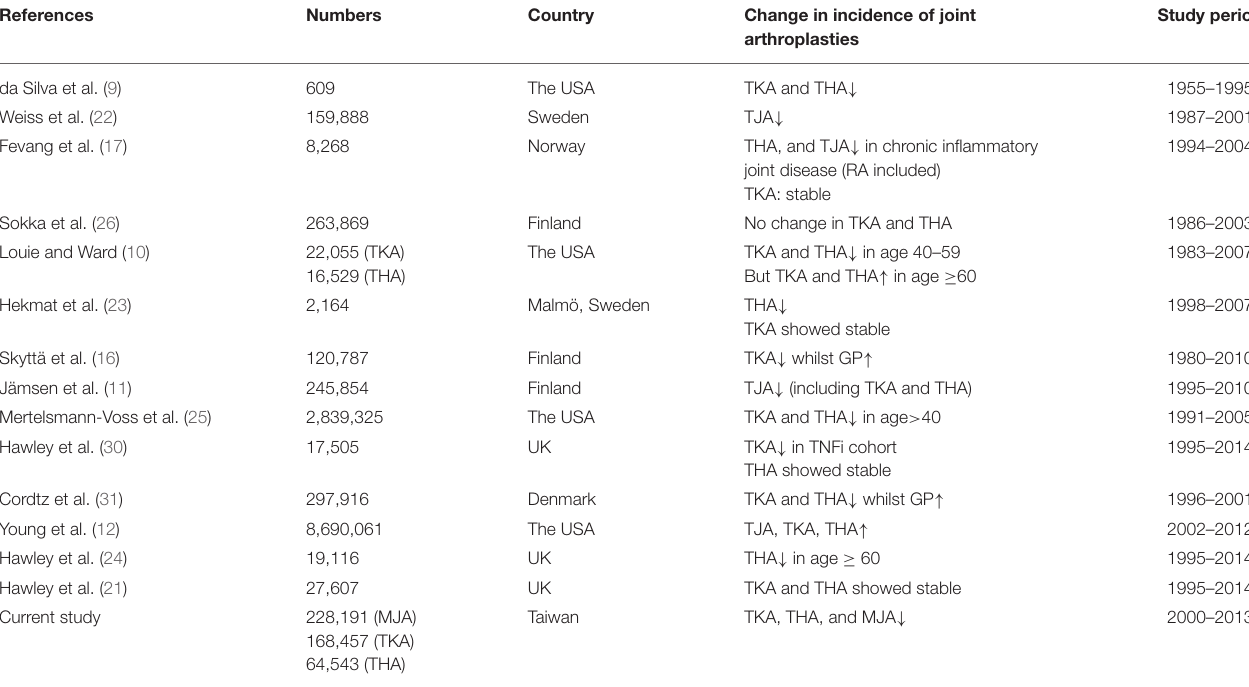
TABLE 5 | Comparison of recent studies targeting incidences of joint arthroplasty surgeries among patients with rheumatoid